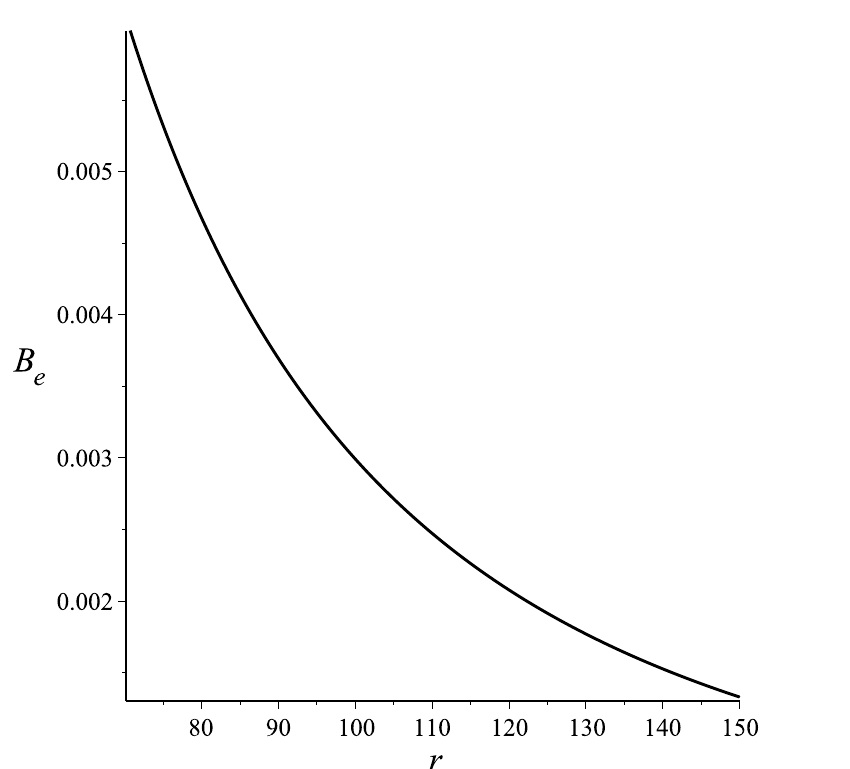
Figure 3 . The equatorial magnetic field, as a function of the radial coordinate outside the event horizon, for an extremal AdS 4 -Kerr-Newman magnetic black hole with L = 100 , a = 50 , P = 501 . 3 . (Units are Planck